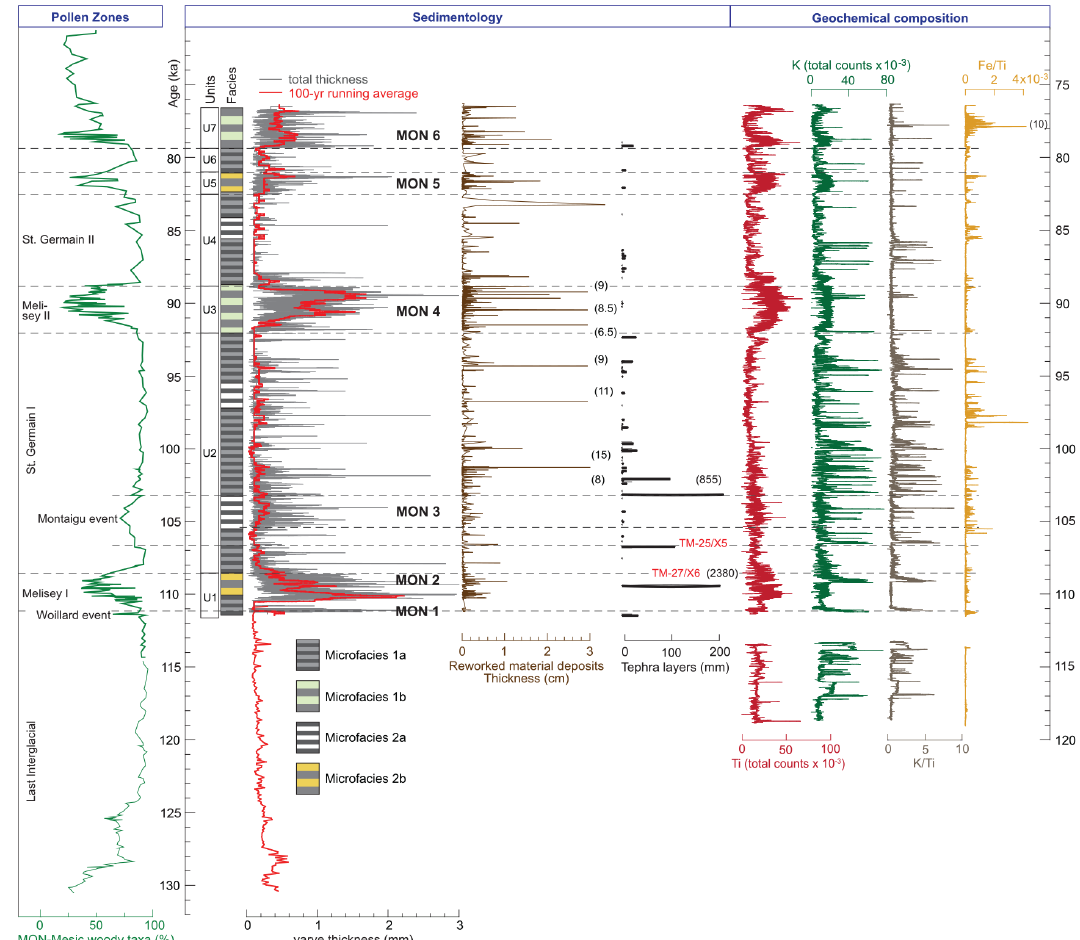
Figure 4. Environmental and climate proxies. From left to right: mesic woody taxa percentages (decadal resolution) on MON-2014 timescales (modified from Brauer et al., 2007) and pollen sub-zones; schematic lithological profile of the study interval; varve thickness variability (grey line) and 100-year average sedimentation rate (red line; data for the interval 112–133ka have been taken from Brauer et al., 2007); thickness variability reworked material deposits; thickness of the primary tephra layers; distribution of the Ti and K as derived from µ XRF measurements and the K / Ti and Fe / Ti ratios throughout the sediment